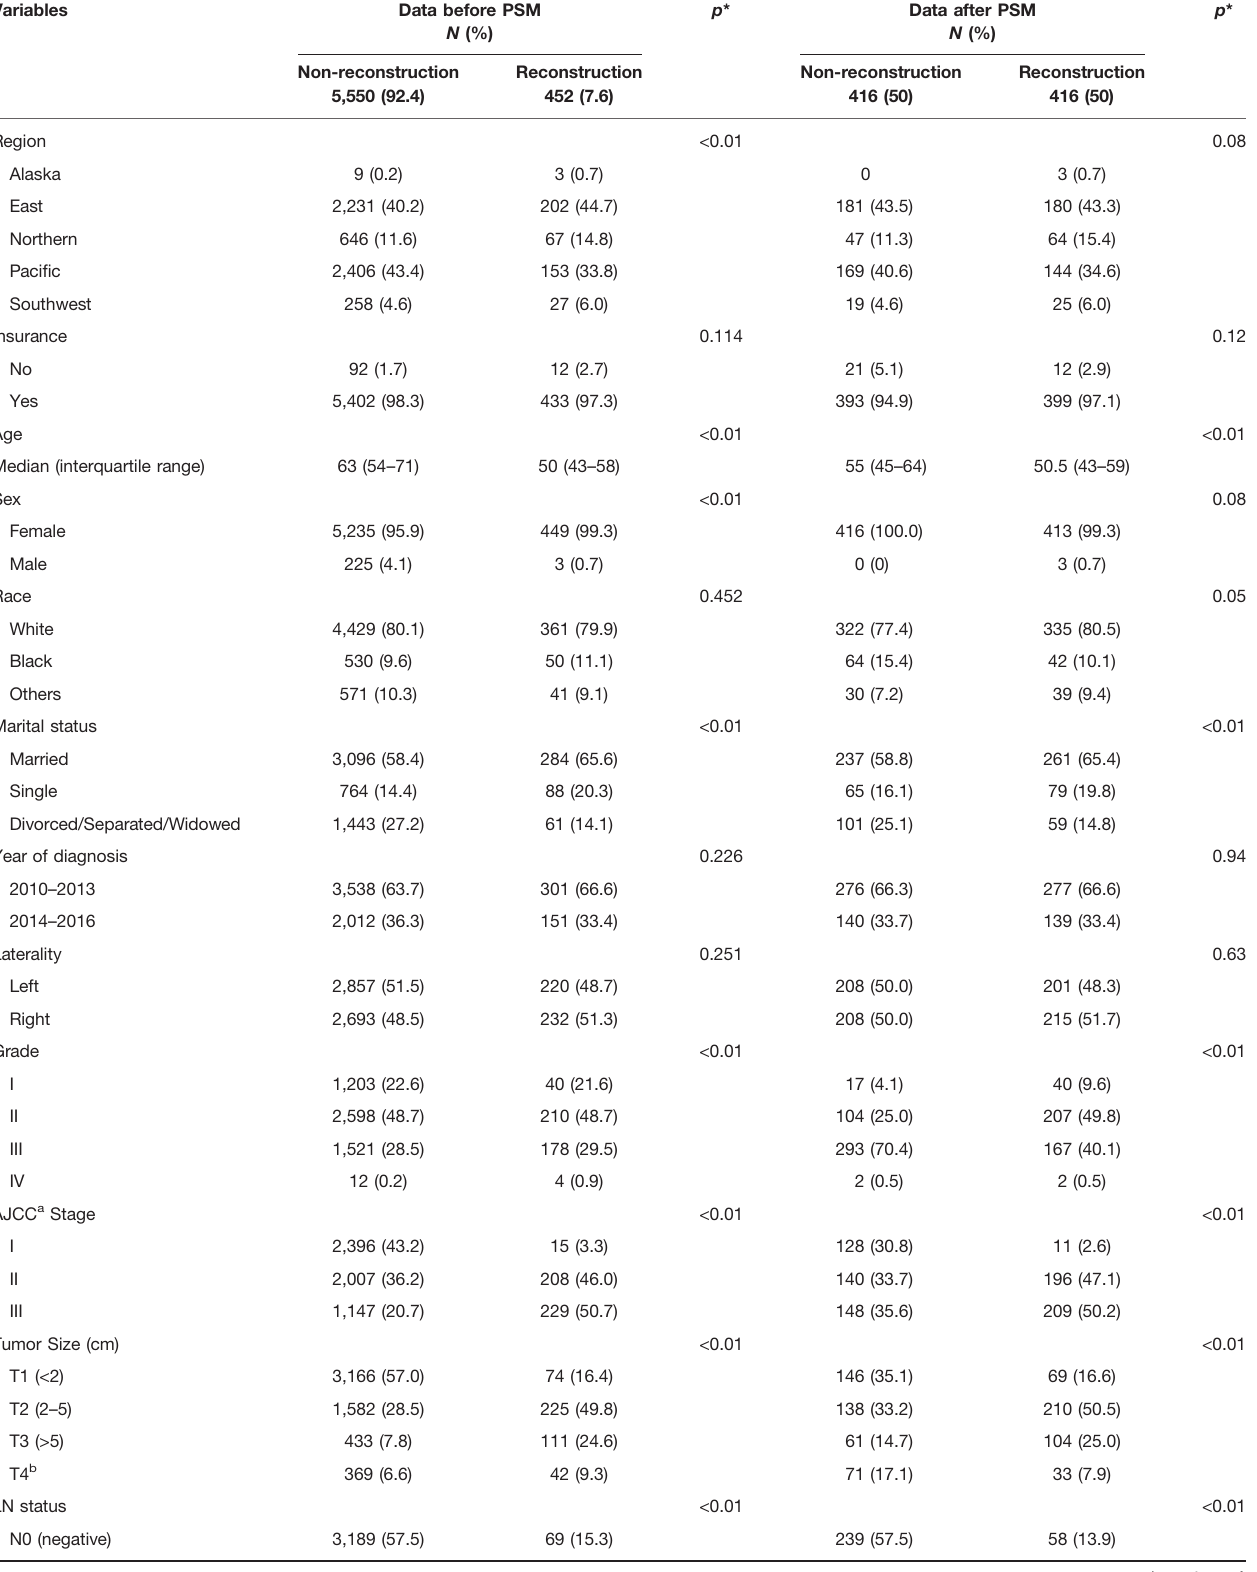
TABLE 1 | Clinicopathological features of the central and nipple breast cancer